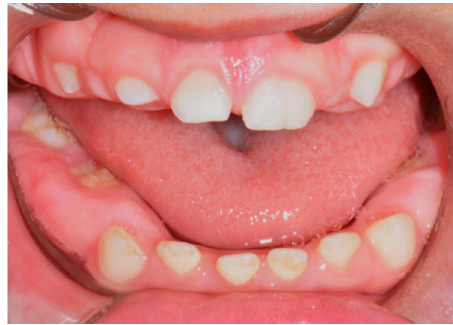
Figure 5. Post-operative photo: soft tissue healing 3 months later.